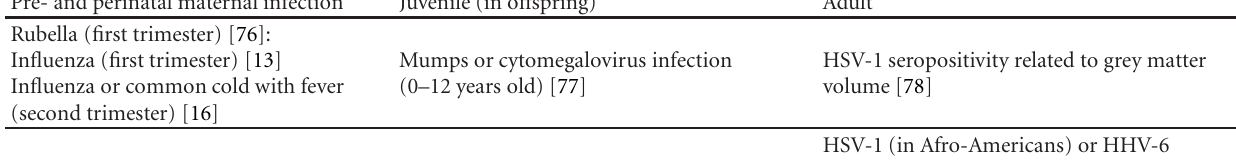
Table 1: Some of the pathogens implicated in Schizophrenia, either in relation to maternal infection, or to infection in later life. Pre- and perinatal maternal infection